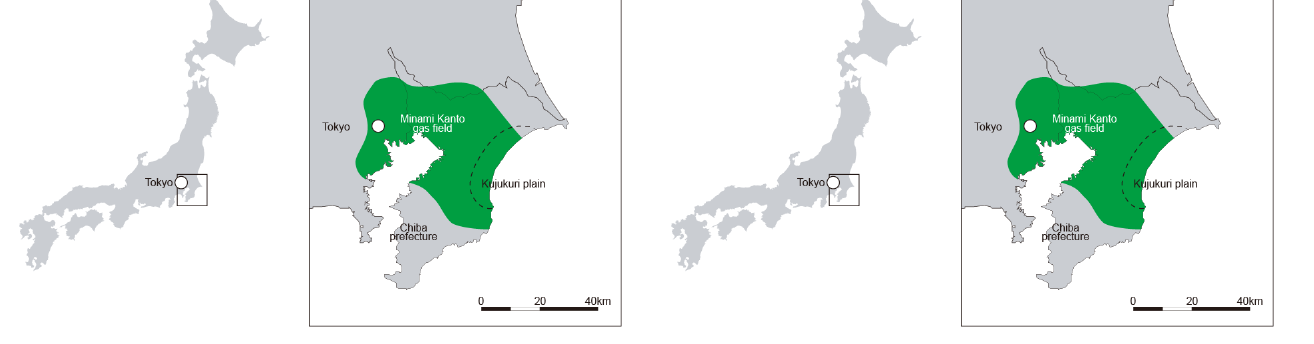
Figure 3. In situ formation compaction monitoring